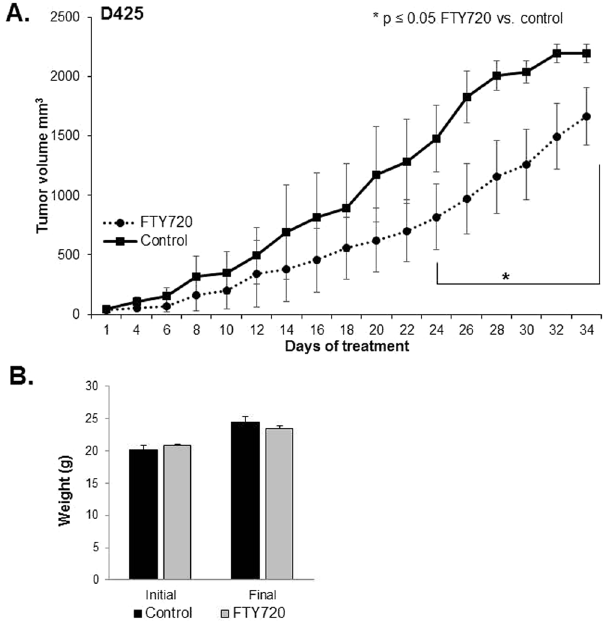
Figure 6. FTY720 decreased medulloblastoma tumor growth in vivo . ( A ) D425 cells (2.5 × 10 6 cells in 25% Matrigel ™ ) were injected into the right flank of 6-week-old, female, athymic nude mice. When tumors reached an average of 100 mm 3 , mice were randomized to receive either vehicle (N = 7) or FTY720 (10 mg/kg/day) (N = 8) for 5 weeks. Animals treated with FTY720 ( closed circles ) had significantly smaller tumors than those treated with vehicle alone ( closed squares ). ( B ) Mice were weighed at the beginning of the experiment and at the time of euthanasia. There was no significant difference in animal weights between those treated with vehicle and those treated with